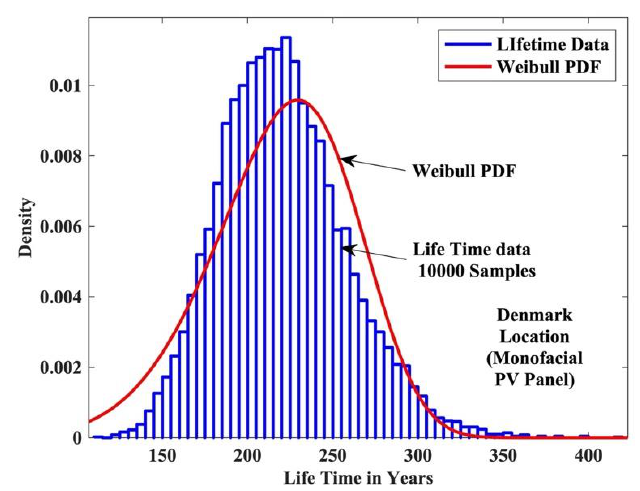
Figure 12. Lifetime distribution of the PV inverter at the location in Denmark.